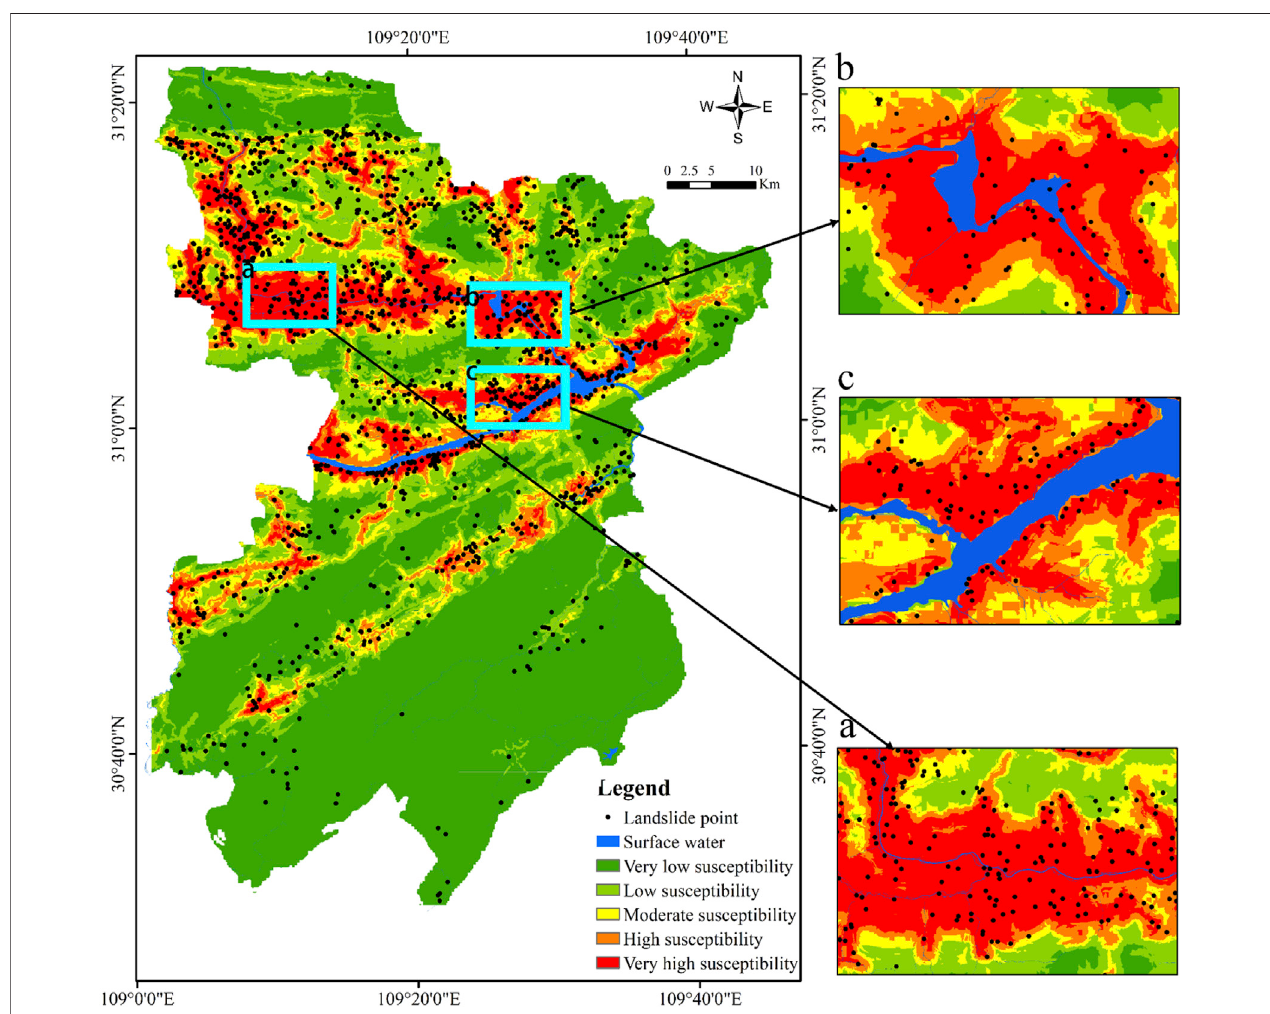
FIGURE 6 | Landslide susceptibility mapping based on the LR bo model vs. the geospatial distribution of historical landslides.